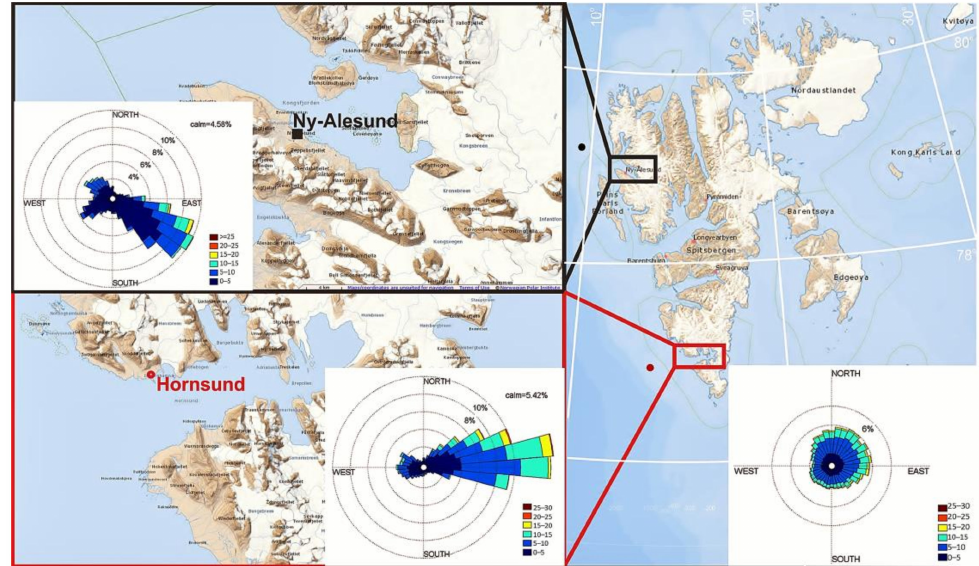
Figure 1. Map of research area: Spitsbergen, the main island of the Svalbard archipelago with insets showing the two discussed fjords. Local wind roses for Ny-Ålesund station for the years 1992– 2013, for Hornsund station for the years 1993–2013 and large-scale wind rose (from NCEP/NCAR reanalysis) for the years 1992–2013 are presented [13]. Dots on the right map are selected points in the open sea of about 60 km from the stations, with coordinates: 79.125 ◦ N, 9.125 ◦ E and 76.875 ◦ N, 13.250 ◦